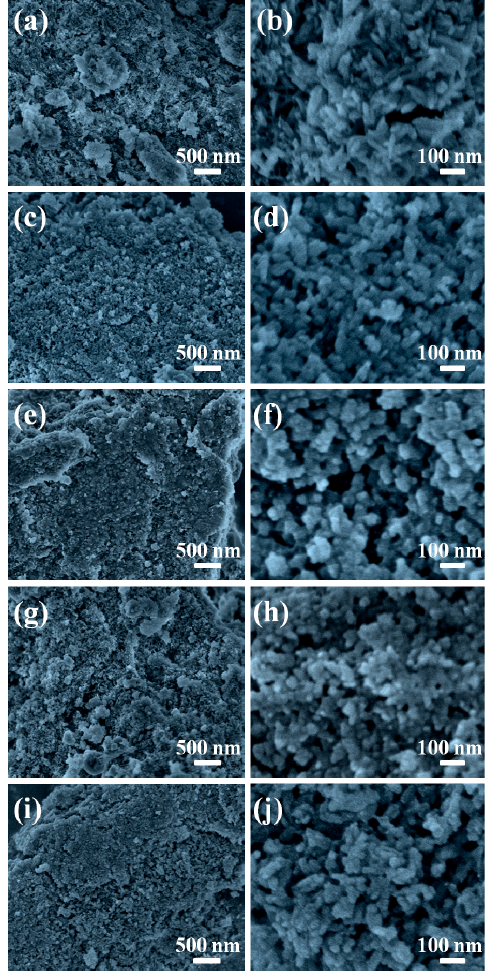
Figure 4. FE-SEM images of the cellulose/HA nanocomposites prepared by microwave-assisted hydrothermal method at 150 °C for 10 min using different phosphorus sources: ( a , b ) NaH 2 PO 4 · 2H 2 O; ( e , f ) ATP; ( g , h ) CP; ( i , j ) FBP and using ( c , d ) NaH 2 PO 4 ·2H 2 O at 150 °C for 60 min. The magnifications for the low-magnification images on the left column are 20,000 and 100,000 times for the high-magnification images on the right